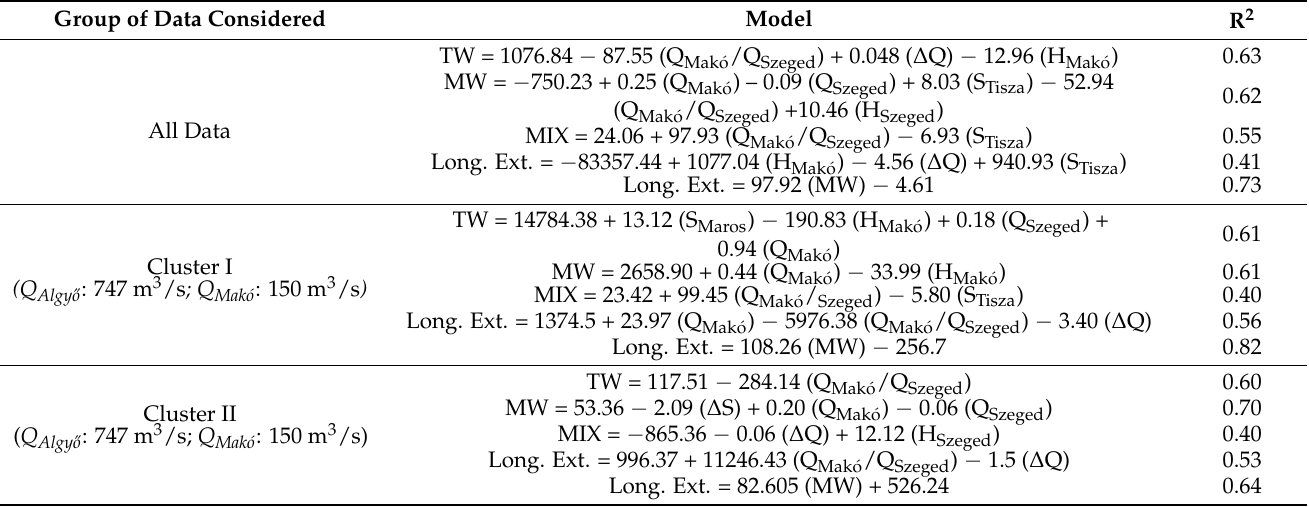
Table 5. Predictive equations for the areal distribution of the mixing waters (TW, MW, and MIX) and the longitudinal extent (L) of MW in the study area for the three groups of data. Group of Data Considered Model R